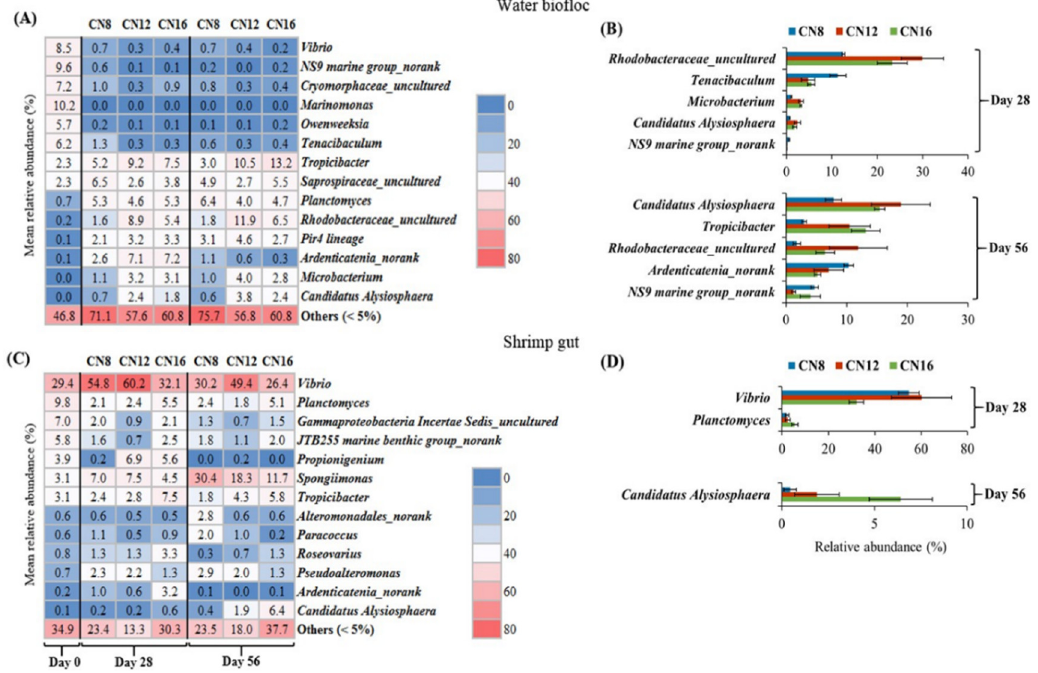
Figure 6. Taxonomy composition of the bacterial community at genus level in water biofloc and shrimp gut from biofloc-based tank systems during an 8-week intensive production trial of P. vannamei with three input C/N ratios (means ± S.D., n = 3). ( A ) Changes in main bacterial genera in water biofloc and their differences among the three C/N ratios. ( B ) Bacterial genera in water biofloc with significant differences in relative abundance among the three C/N ratios. ( C ) Changes in main bacterial genera in shrimp gut and their differences among the three C/N ratios. ( D ) Bacterial genera in shrimp gut with significant differences in relative abundance among the three C/N